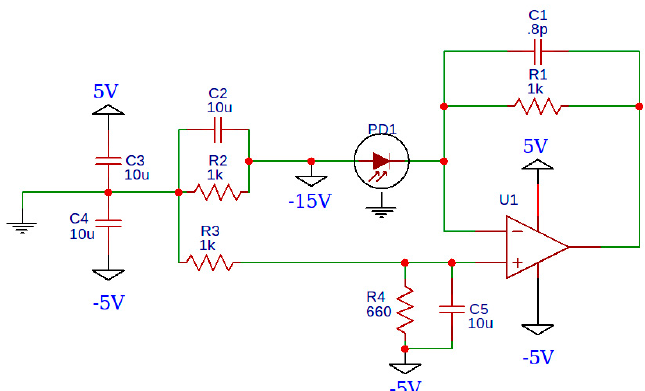
Figure 2. The TIA block schematic. The circuit has some extra bypass capacitors not drawn. C 1 is selected to add the necessary phase lag to compensate the amplifier. The actual value of the capacitor is different than the nominal value, and it takes into account the final parasitic capacitance of the global surface mounted feedback line (including the parasitic capacitance of the feedback resistor).